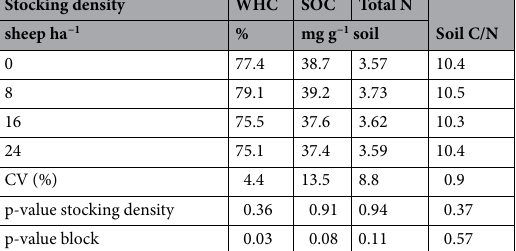
Table 2. Water holding capacity (WHC), SOC, total N and soil C/N ratio of a rangeland soil grazed by 0, 8, 16, and 24 sheep ha −1 in a two year grazing experiment from 2014–2015 on a summer pasture in the Chinese Altai Mountains, Qinghe, China.